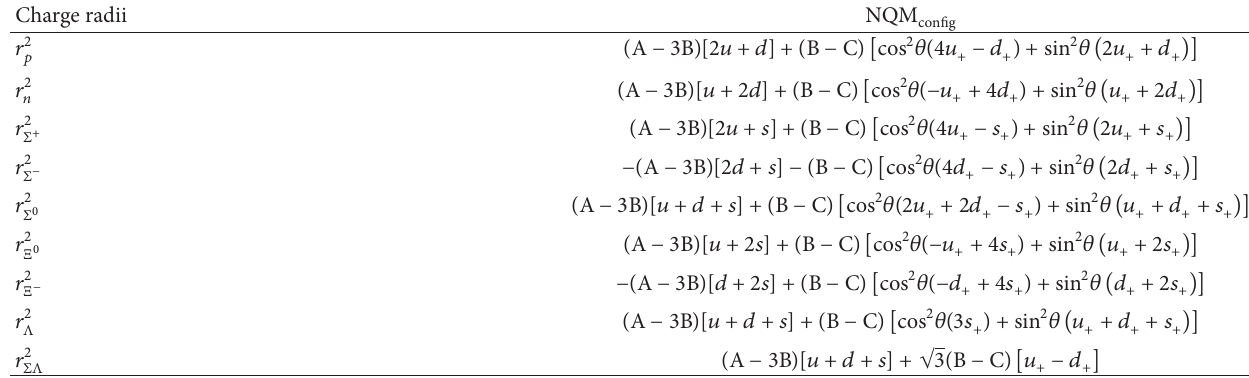
Table 1: Charge radii of octet baryons in NQM be calculated by substituting 𝜃 = 0 .